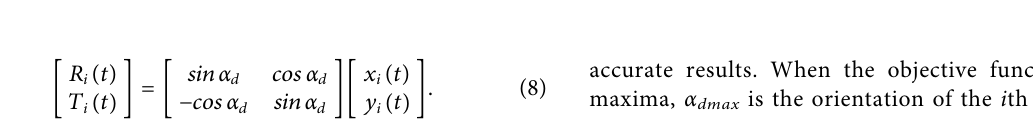
FIGURE7| Field zero-offset VSP databefore rotation. (A) X-component. (B) Y-component. (C) Scalar fi eldofthehorizontal components data. (D) Corresponding slope of the scalar fi eld.